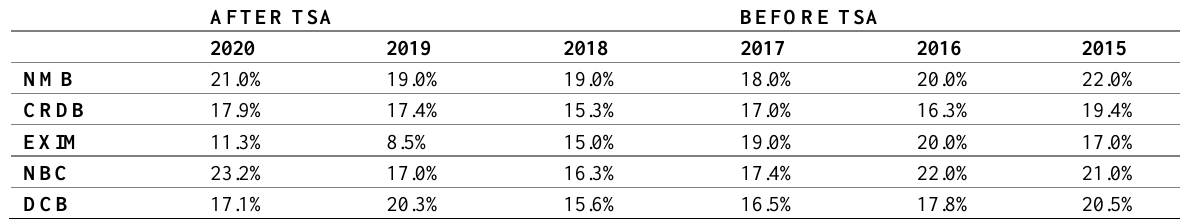
Table 3: Shareholders’ Equity to Total Asset